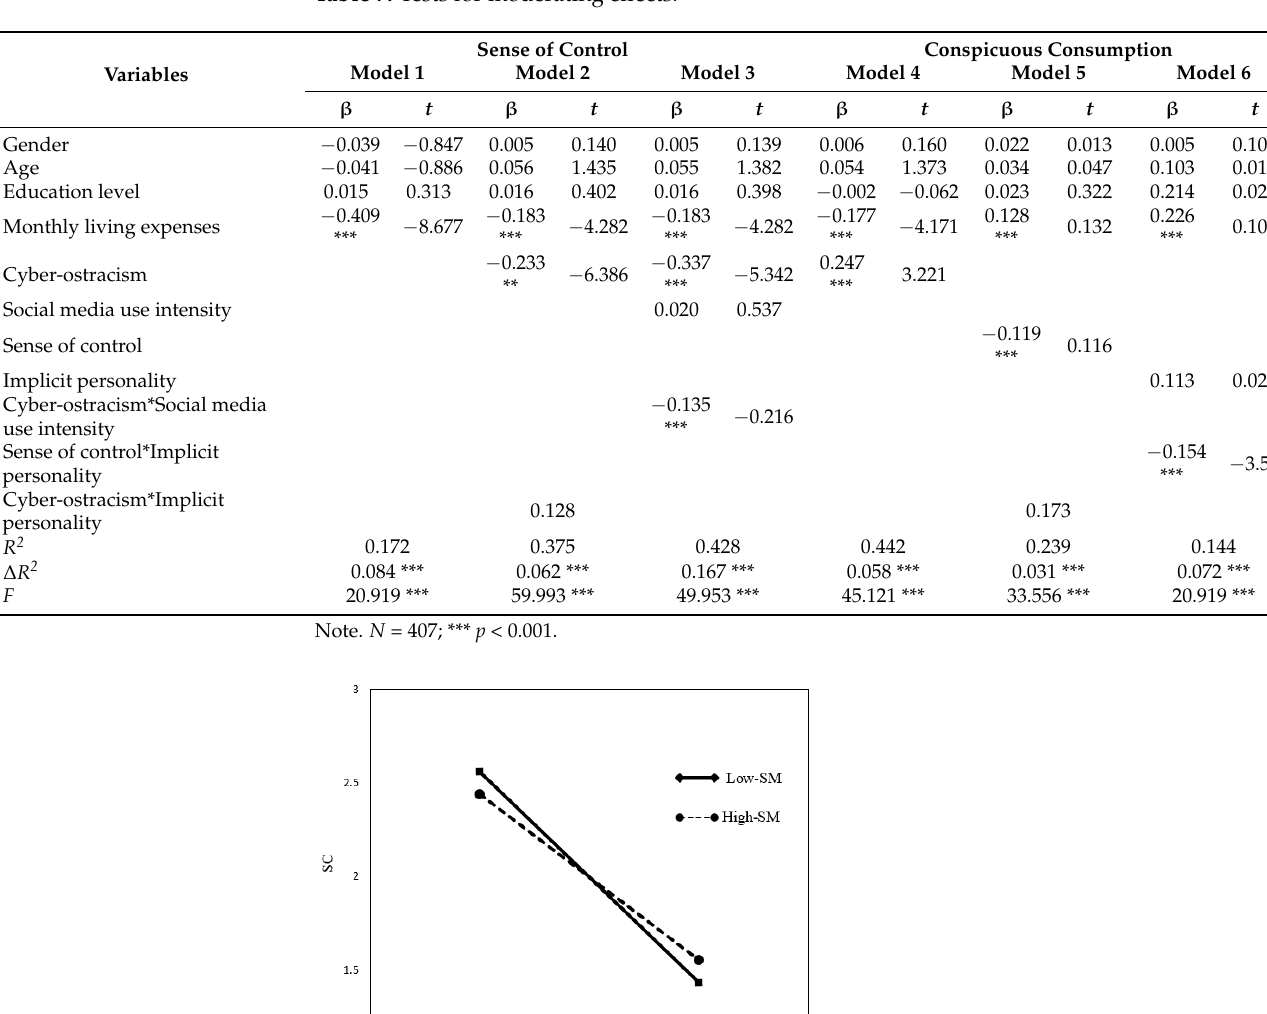
Table 7. Tests for moderating effects.